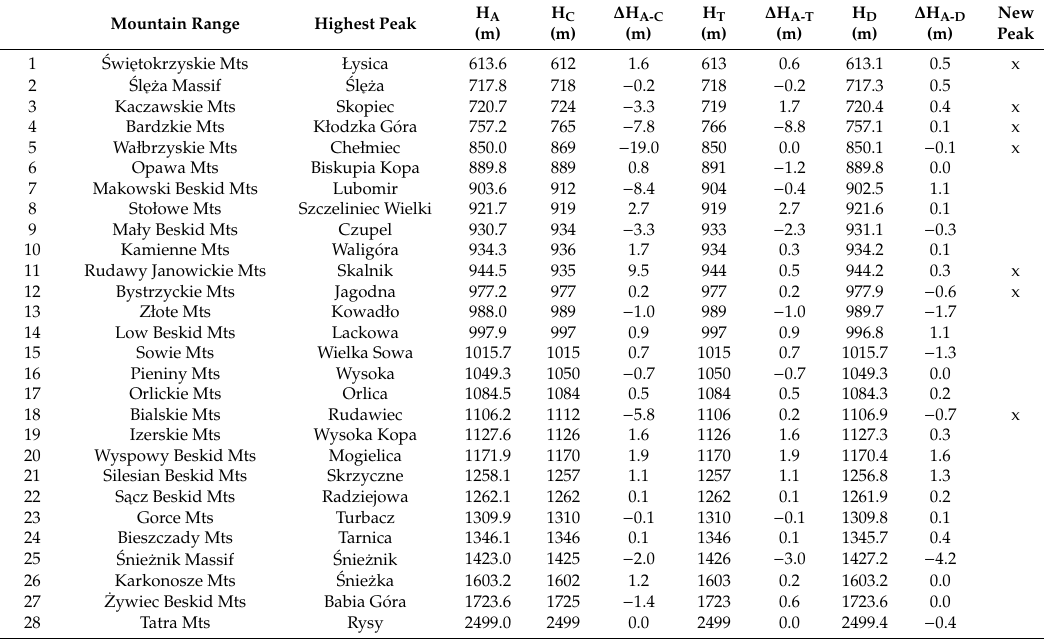
Table 1. Results of the authors’ own measurements and comparison with CPM, TM and DTM data. Mountain Range